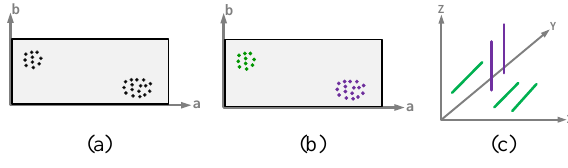
Figure 5. Clustering procedure in the directional attribute subspace: (a) 2D directional attribute subspace, (b) detected peaks in the directional attribute subspace, and (c) parallel lines representing the detected peaks in the spatial domain